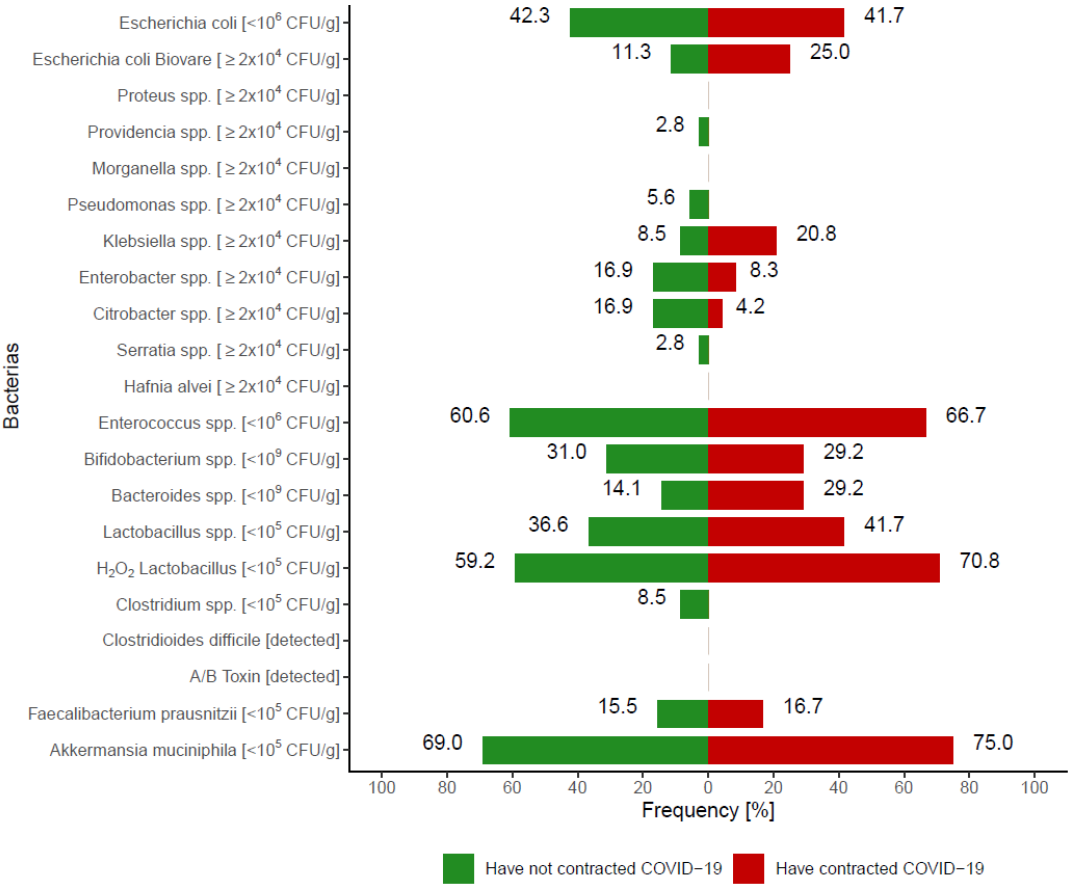
Figure 4. The percentage of people with a number of individual bacteria outside reference values ( p > 0.05).